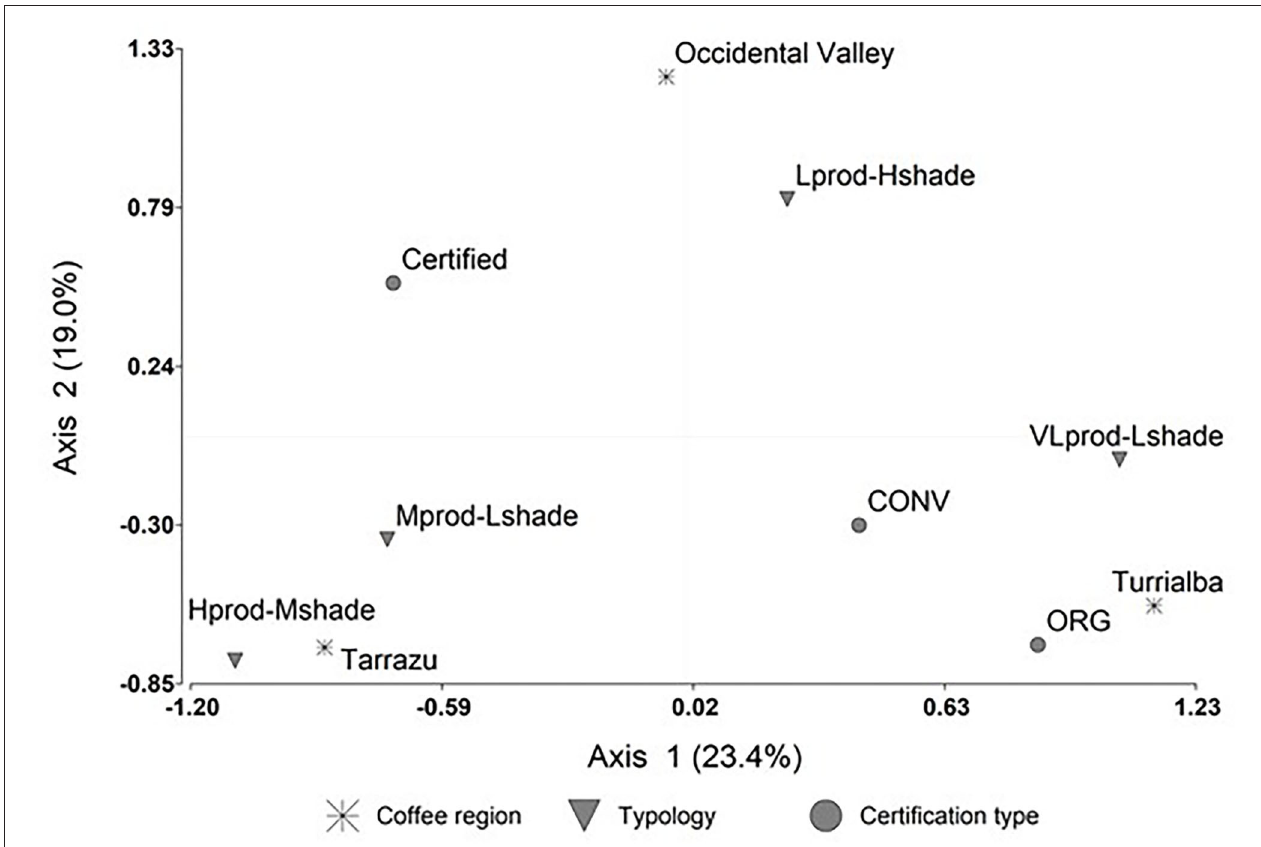
FIGURE 2 | Degree of association between coffee plantation typologies, regions (see Table 1 ) and certification type in Costa Rica using a biplot from multiple correspondence analysis. Key to typologies: Hp-Ms, High productivity, Medium shade; Mp-Ls, Medium productivity, Low shade; Lp-Hs, Low productivity, High shade; Vlp-Ls, Very low productivity, low shade. Key to certification type: ORG, organic, CONV, not certified, certified, all sustainability certifications other than organic.